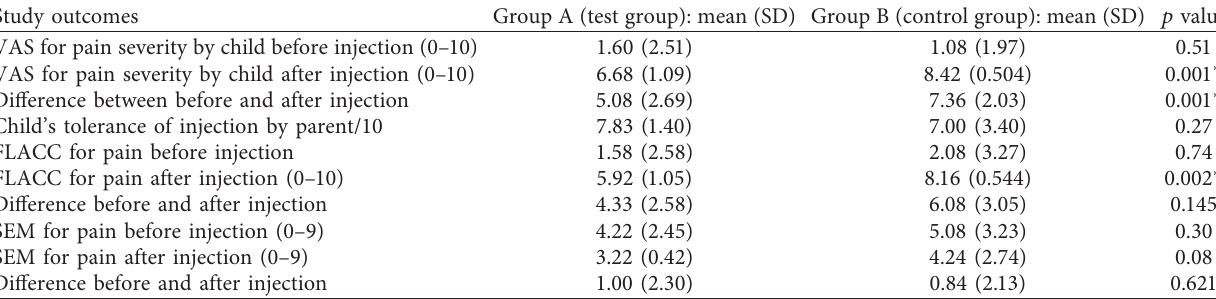
Table 3: Effect of anesthetic interventions on the study